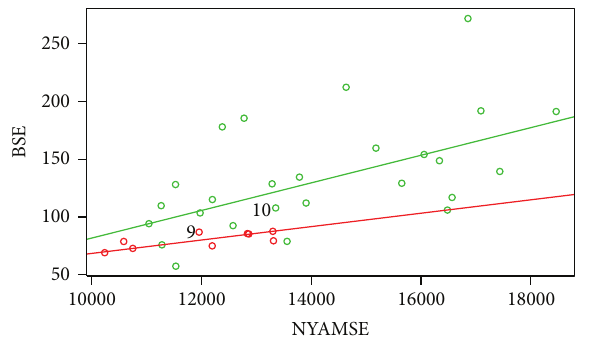
Figure 1: Scatter plot and regression lines of BSE versus NYAMSE. The red points and line correspond to the first 9 observations; the green points and line correspond to the 10–35